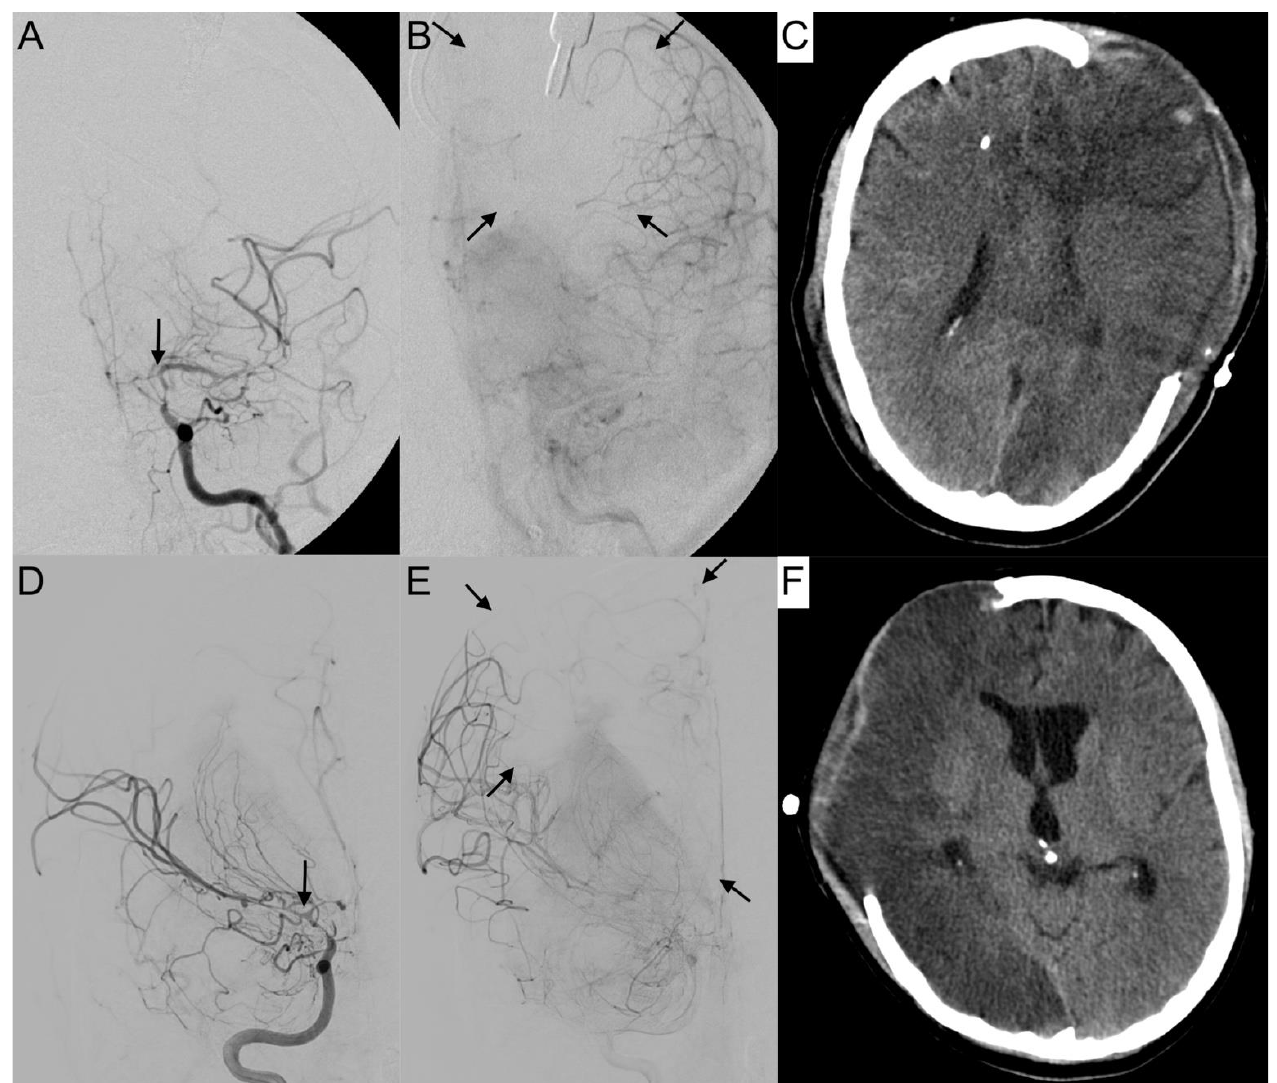
Figure 6. Collapsed collateral supply in severe vasospasm. Angiograms of the left ( A , B ) and right ( D , E ) internal carotid arteries (ICA) with severe vasospasm (grade 3) affecting the terminal portion of the ICA ( A , D : arrows) are shown. In the parenchymal phase, the breakdown of collateral supply resulted in a large perfusion deficit ( B , E : arrows), leading to subtotal hemispheric infarction ( C , F ) in computer tomography. Both patients revealed a distinct outcome with mRS 3 ( A – C ) and mRS 5 ( D , E ), depending also on the laterality of language ability.